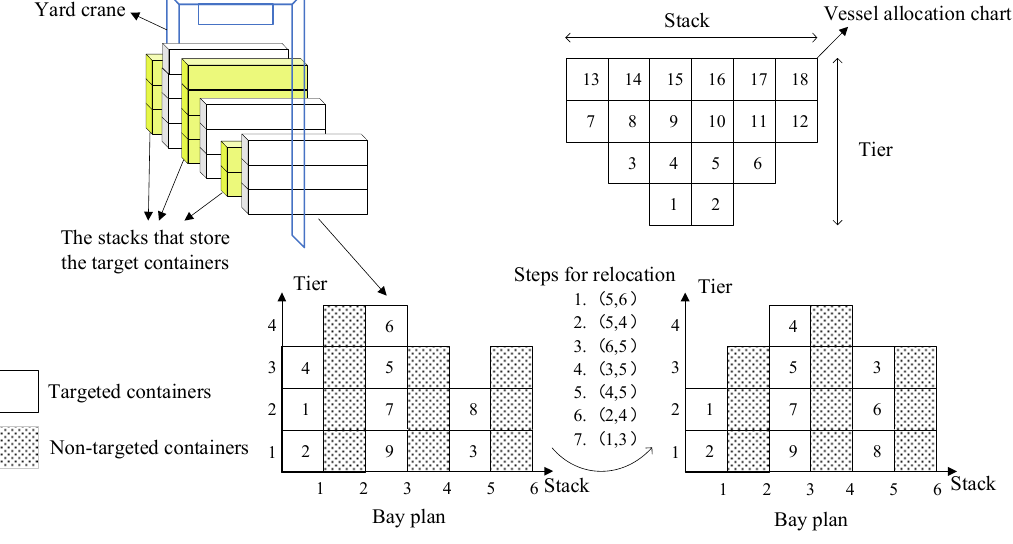
Figure 1. Pre-marshalling process.